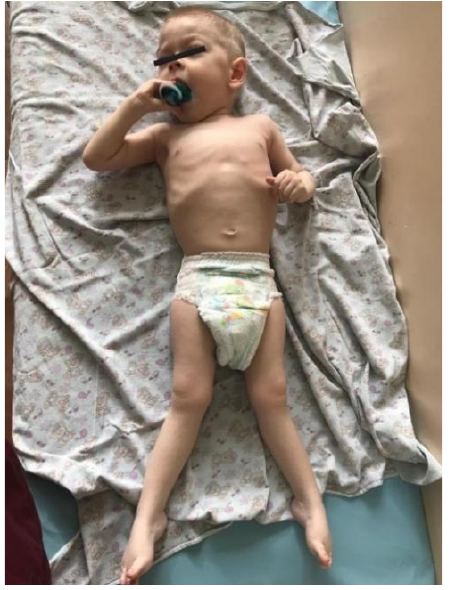
Figure 2. Spastic paraplegia in the proband’s lower limbs.